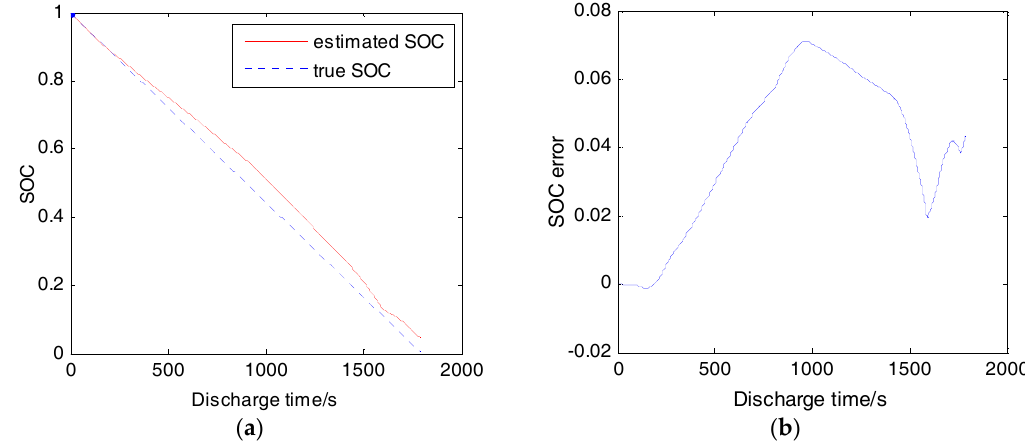
Figure 12. SOC estimation result (25 °C, 2 C): ( a ) Estimated SOC and true SOC; ( b ) SOC estimation error.